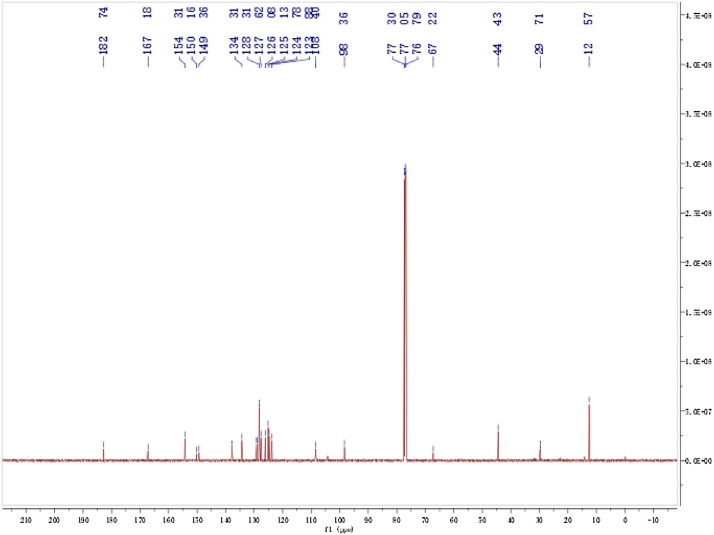
13CNMR of the RS in DCl3.13CNMR(CDCl3, 300 MHz) δ12.565, 44.434, 67.217, 98.355, 108.896, 124.780, 125.133, 126.076, 127.621, 128.309, 134.312, 149.362, 150.159, 154.311, 167.185, 182.745. ESI-MS:m/z: 592.1(M+).